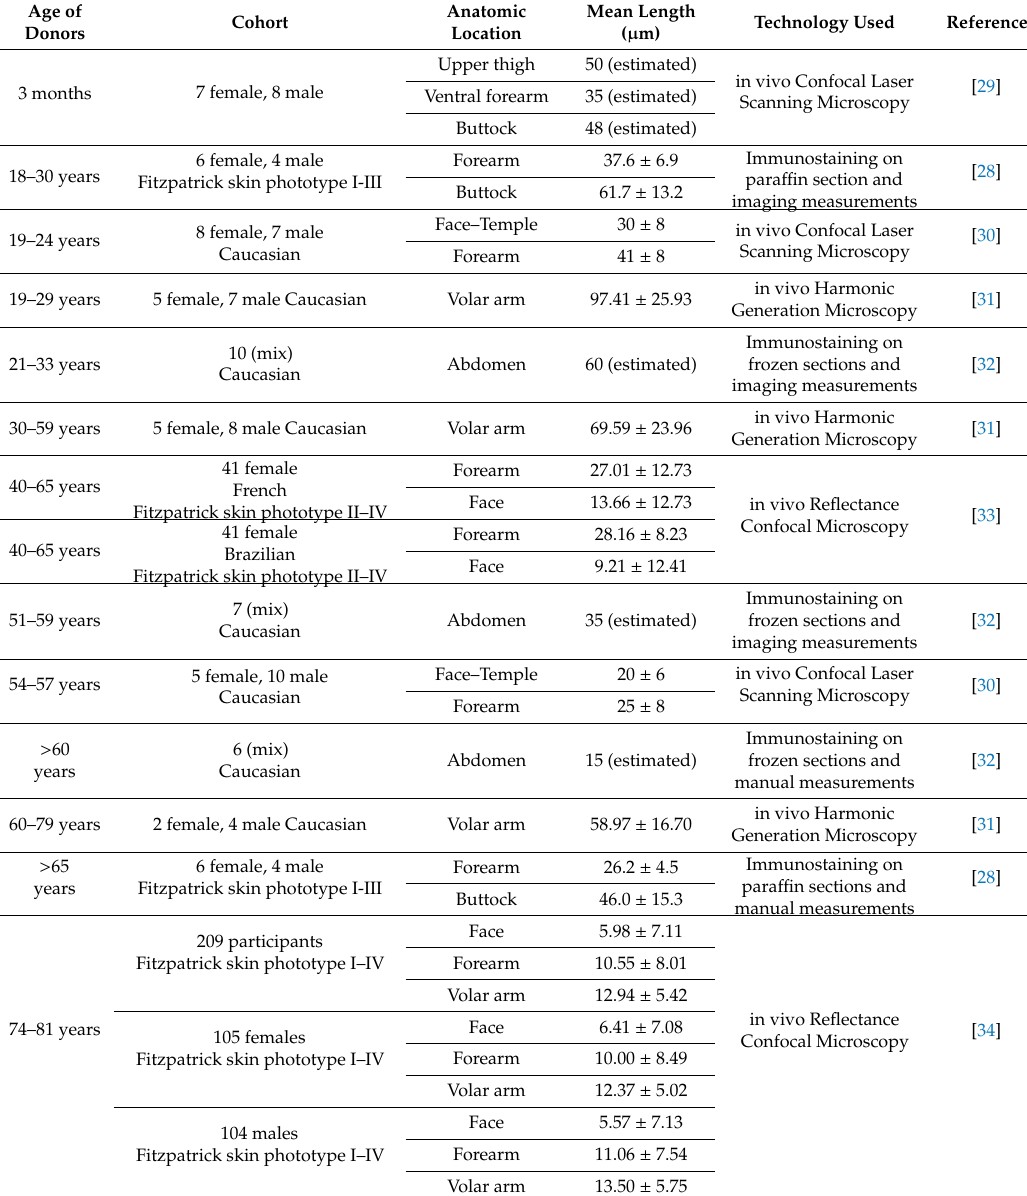
Table 1. Length of epidermal rete-ridges in human skin over age in various anatomical